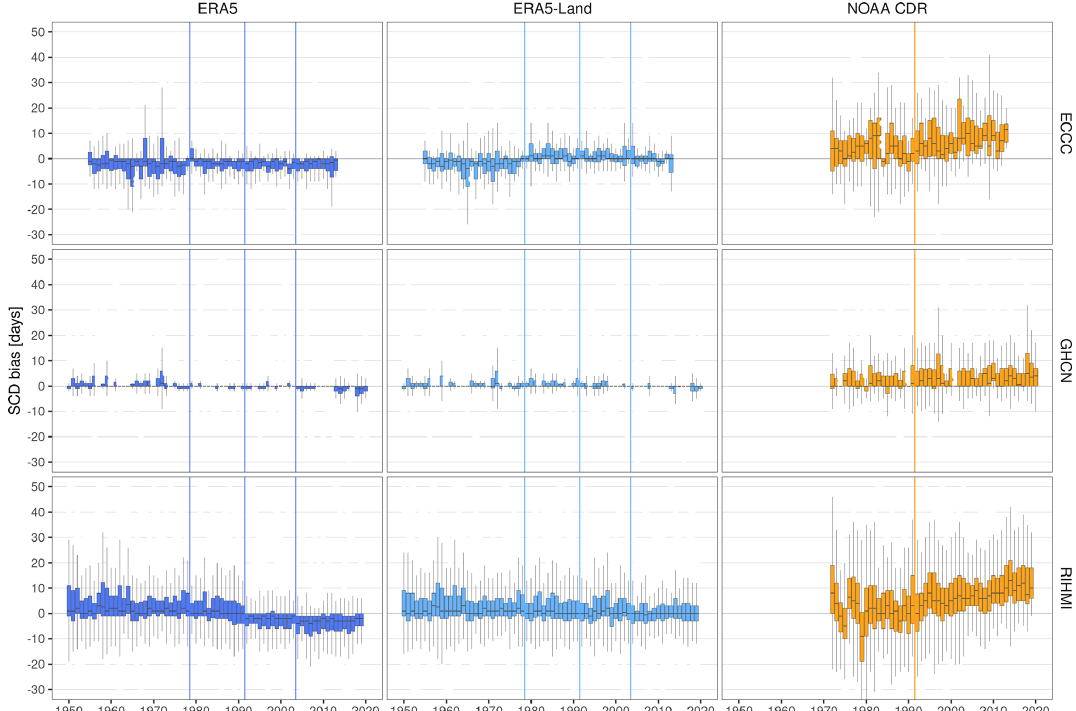
Figure A6. Temporal stability of the bias (product – station) in snow cover duration (SCD) per product and network during SON. Vertical lines show the years when the potential discontinuities/trends in each product occur/start.